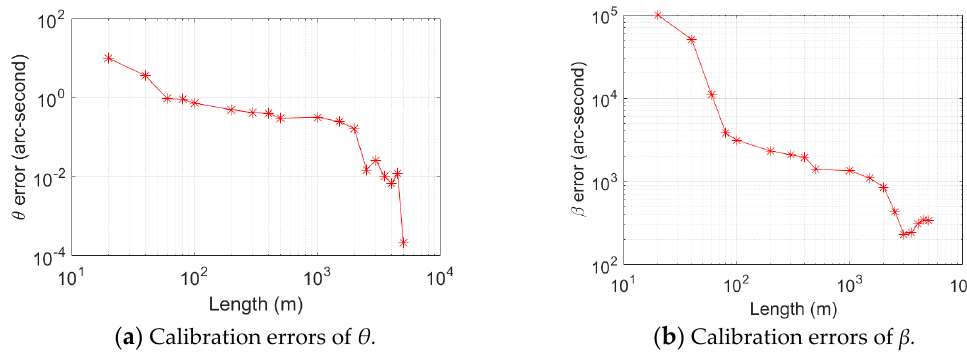
Figure 13. Calibration errors of θ and β with different track lengths. The curves are plotted in logarithmic coordinates.